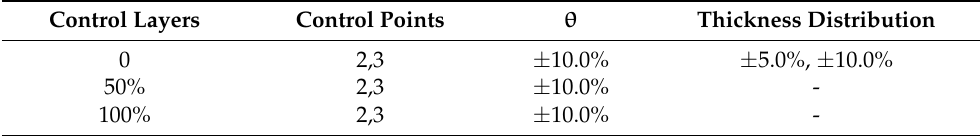
Table 4. Ranges of blade design